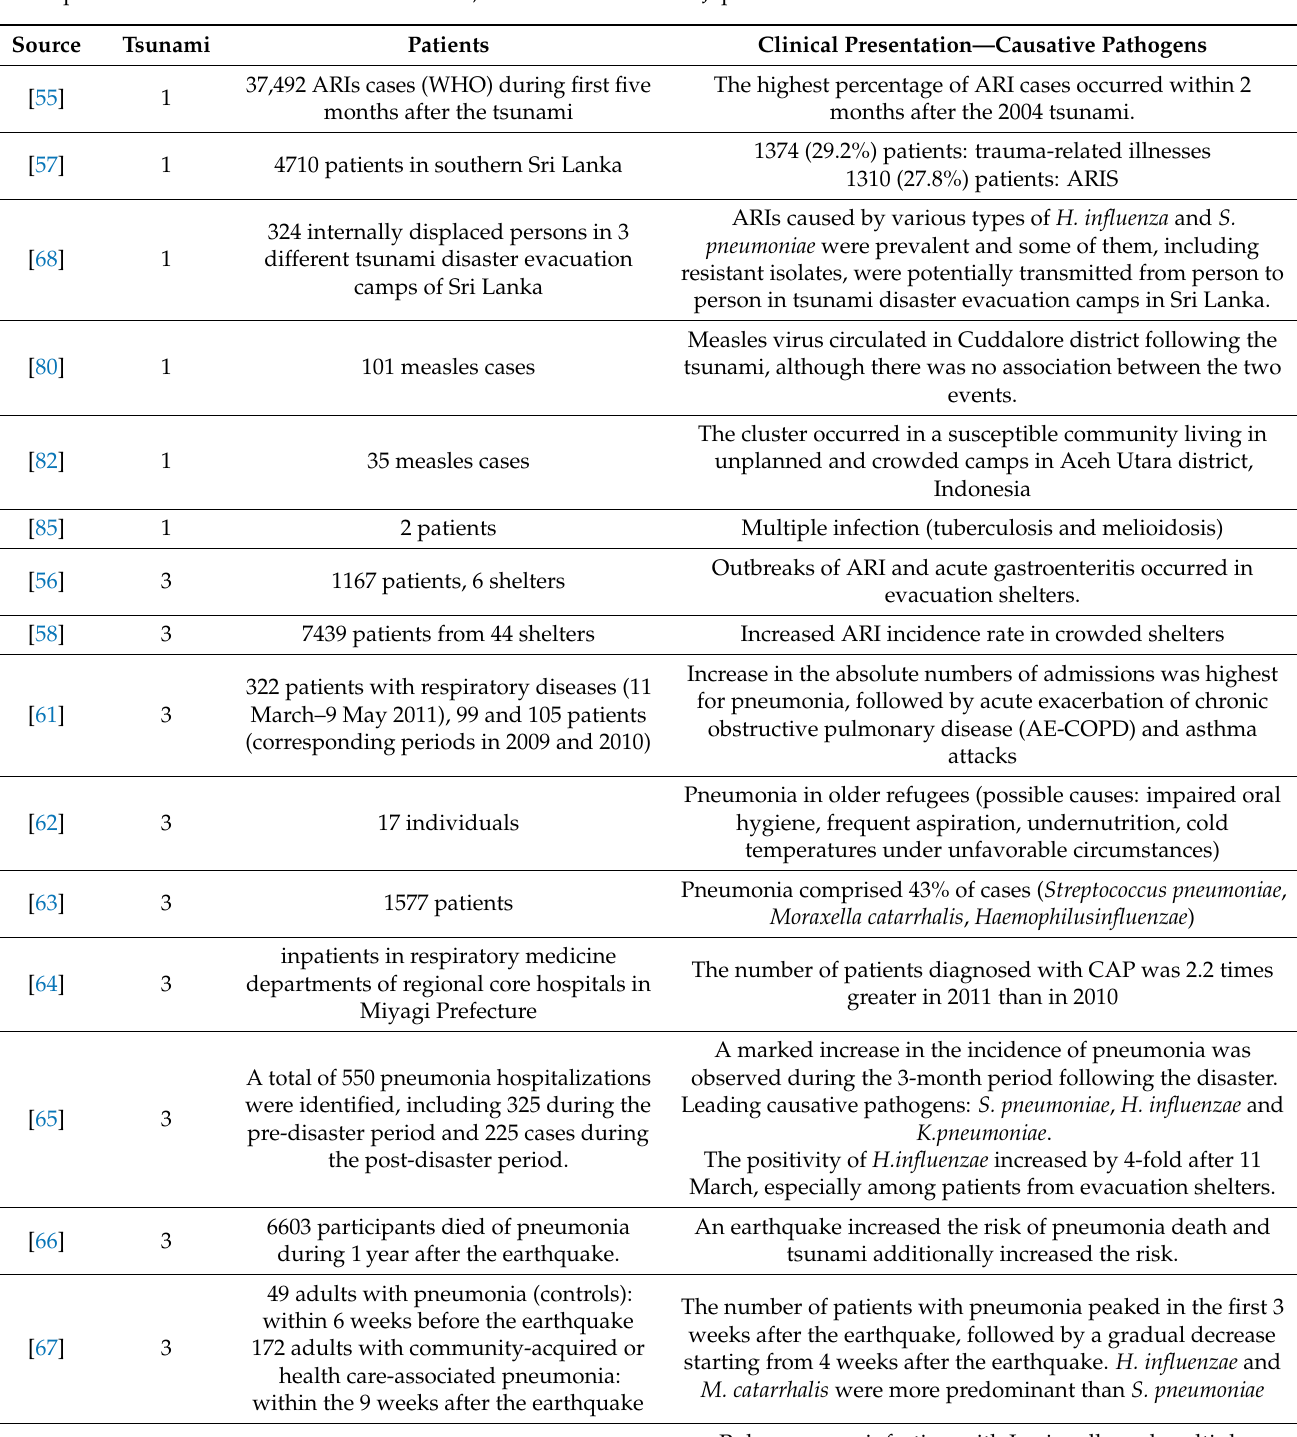
Table 2. Included studies referring to the occurrence of acute respiratory infections clustered by event and disease/pathogen reported. 1: the 2004 Indian Ocean tsunami, 3: the 2011 Great East Japan tsunami. Source